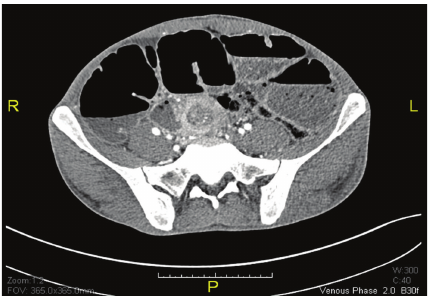
Figure 2: Abdominal CT scanning on day 19 (day 15 after symptoms) showing severely dilated small bowel and characteristic intussusception features: “target lesion” or “doughnut sign” and sausage-shaped mass.